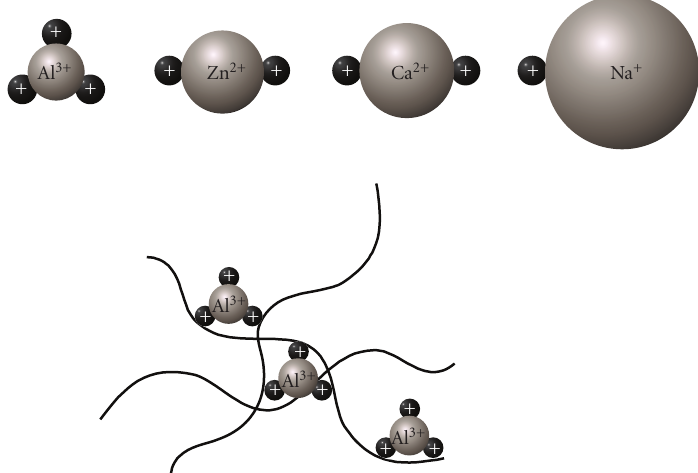
Figure 2: Cross-linking of protein by Al 3+ . Al 3+ has a relatively small ionic radius (50pm) with 3 positive charges; here it is compared to other metal ions such as Zn 2+ (74pm), Ca 2+ (99pm), and Na + (95pm). These characteristics enable Al to be an e ff ective cross-linker of proteins.